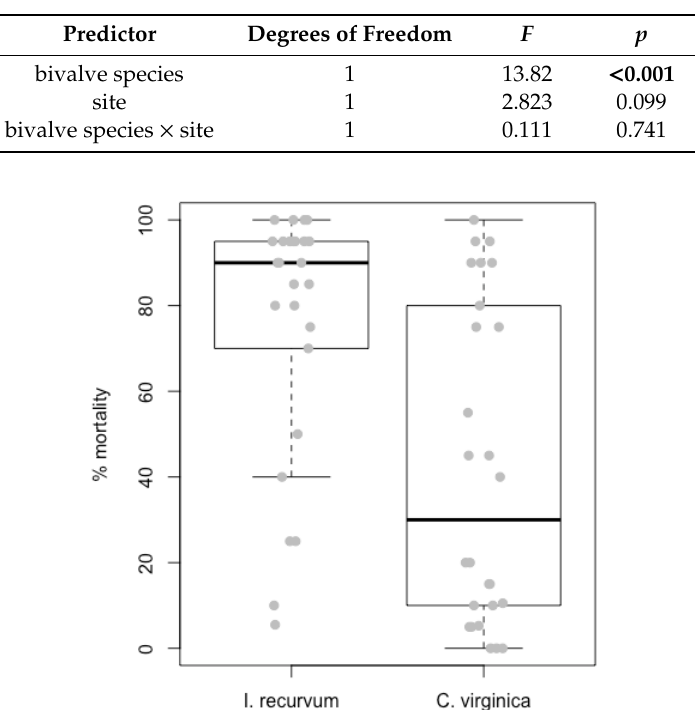
Table 2. Summary statistics from a two-way analysis of variance (ANOVA) of the effects of species and site on predation mortality in the field. Significant p -values are in bold.